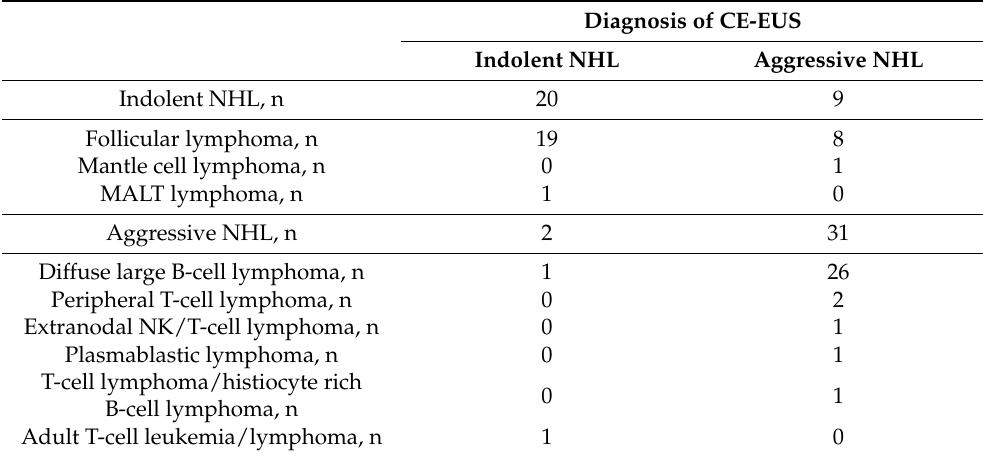
Table 6. The diagnostic performance of contrast-enhanced endoscopic ultrasound with qualitative and quantitative evaluations compared with qualitative